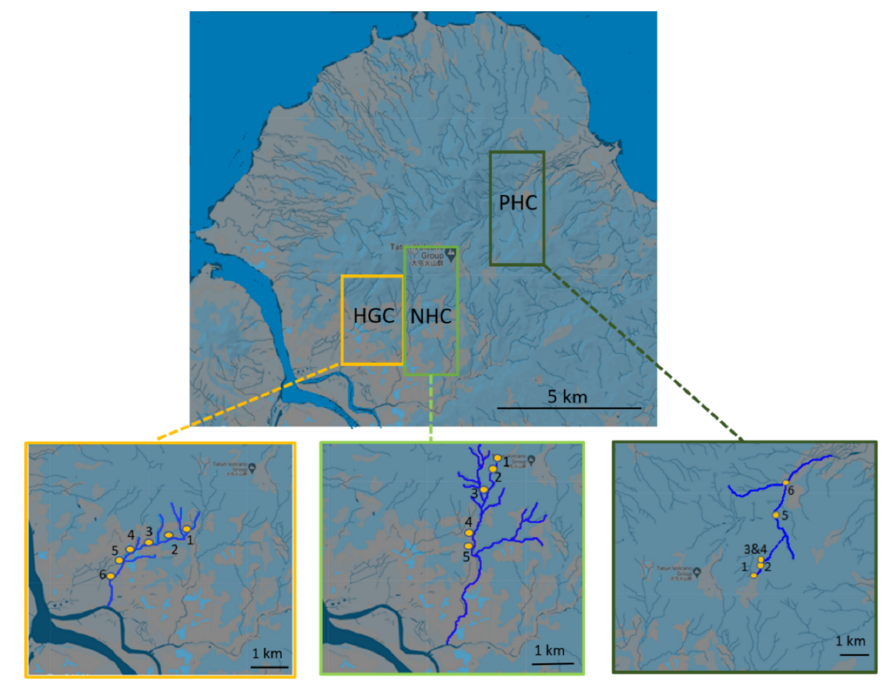
Figure 1. Distribution of sampling locations of HGC, NHC and PHC, TVG basin. The exact sampling site details are given in Table